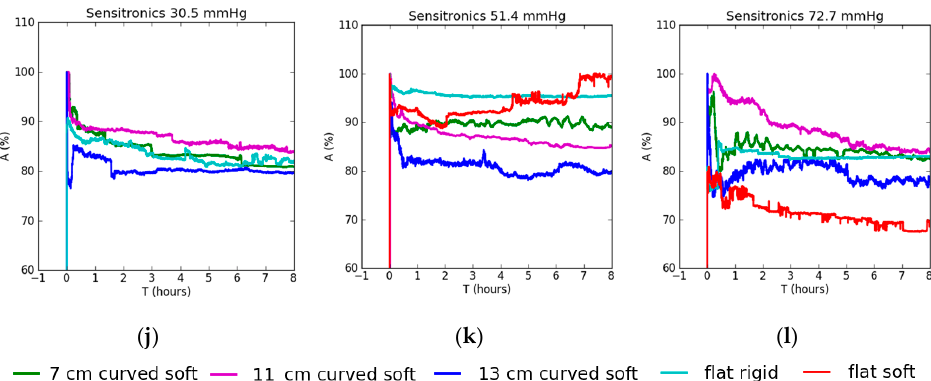
Figure 5. Static testing results for the Sensitronics sensor with applied pressure shown in the title: ( a – c ) sensor output voltage reading; ( d – f ) sensor pressure reading when flat rigid calibration is used for all tests; ( g – i ) sensor pressure reading when sensor is recalibrated before each test. Dotted lines show corresponding applied ‘gold standard’ pressures; ( j – l ) accuracy of the sensor pressure reading. Table 2. Average accuracy in static pressure measurements.